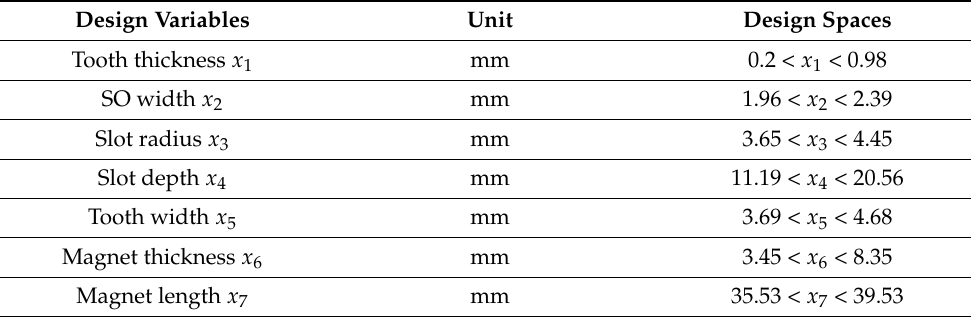
Table 5. Design variables and their